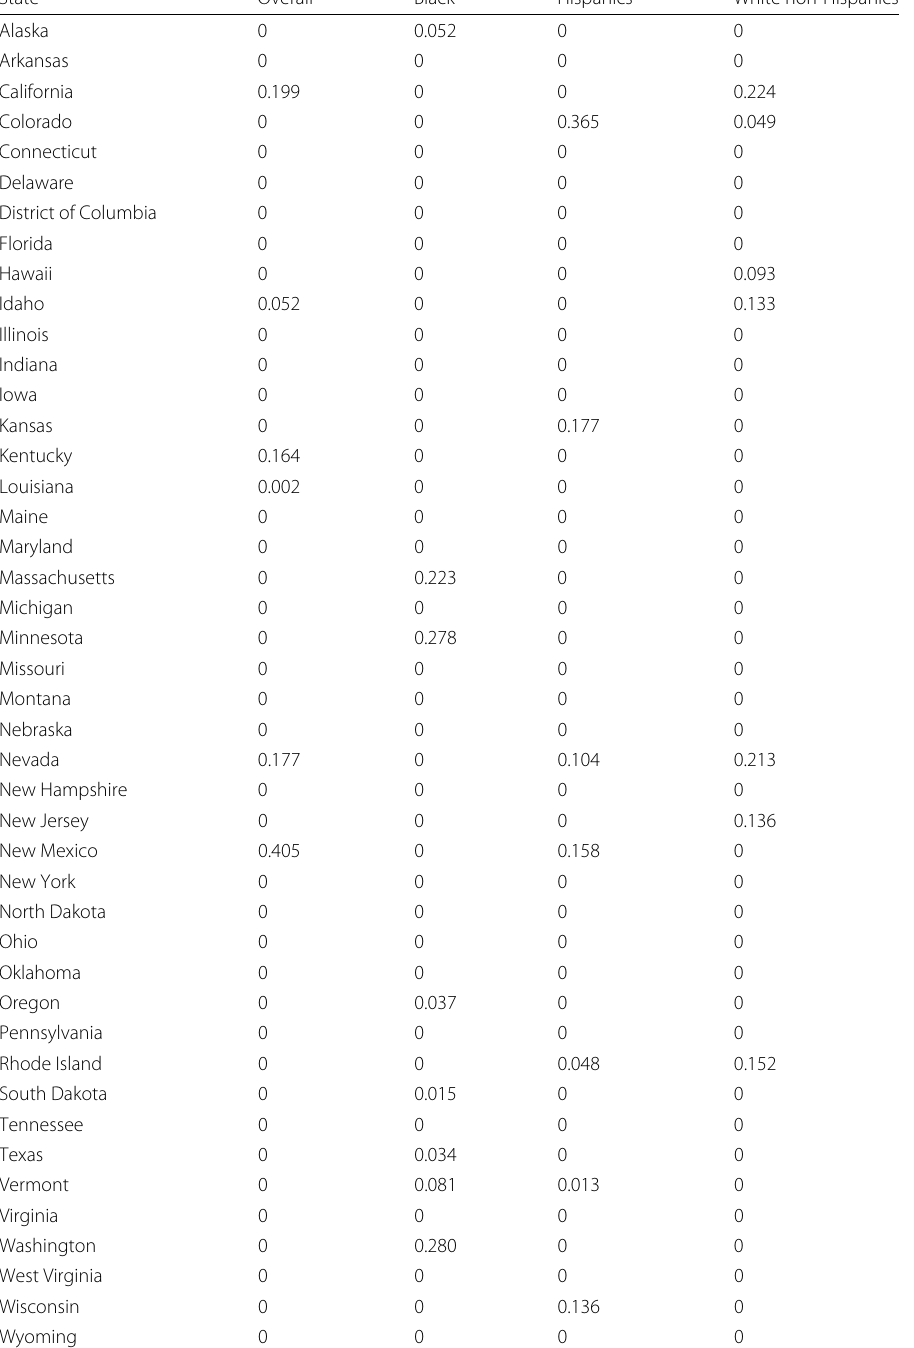
Table 5 Weights used in constructing synthetic Arizona for college enrollment rates analyses in Table